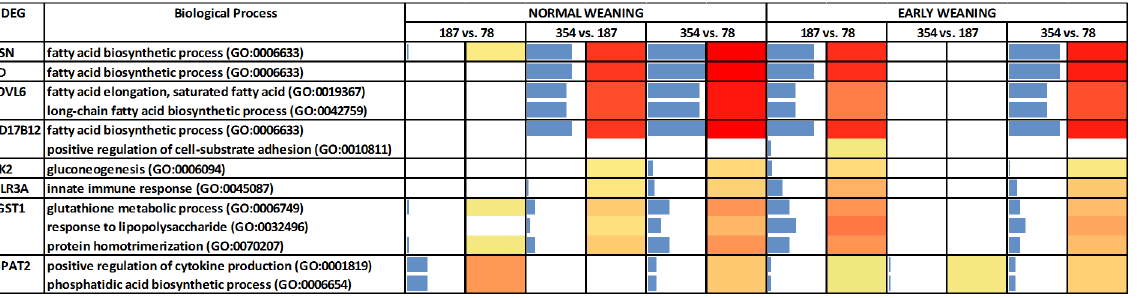
Fig 5. Significant biological processes (BP) among the differentially expressed genes reported in Table 3 for each time comparison. Flux represents the direction of each category and the corresponding subcategory (green color = inhibition, yellow color = stable, red color = activation with different color intensities according with the level of up-regulation or down-regulation). Blue bars denote the impact of each biological process.